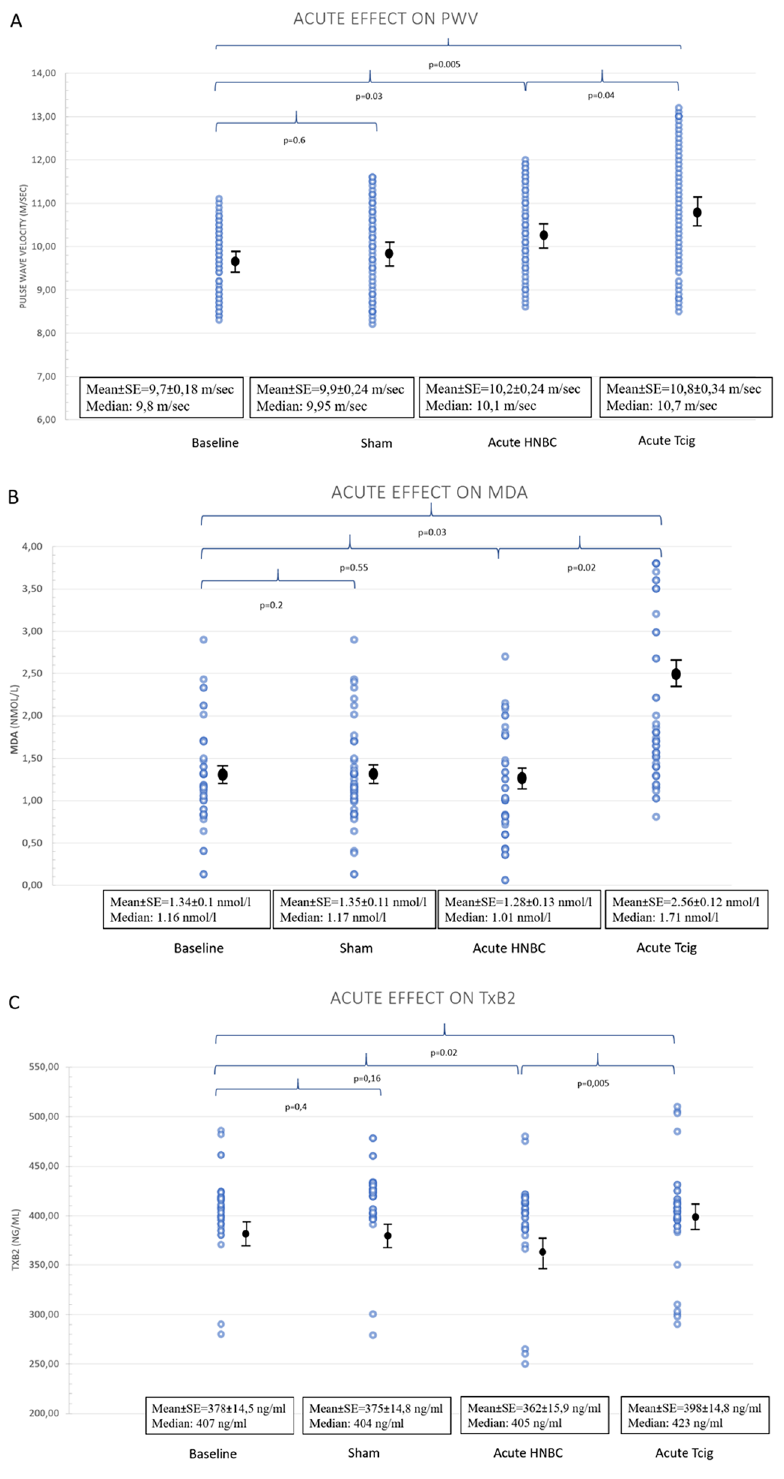
Figure 1. Acute effects of heat-not-burn puffing versus tobacco cigarette smoking. Comparison between the acute effects of heat-not-burn versus tobacco cigarette smoking on ( A ) arterial stiffness, ( B ) oxidative stress burden, and ( C ) platelet activation status. HBNC showed a smaller increase of PWV than tobacco cigarette. All biomarkers are impaired following Tcig smoking, in contrast with HNBC puffing. PWV carotid-femoral pulse wave velocity, HNBC heat-not-burn cigarette, MDA malondialdehyde, Tcig tobacco cigarette, TxB2 thromboxane B2, SE Standard